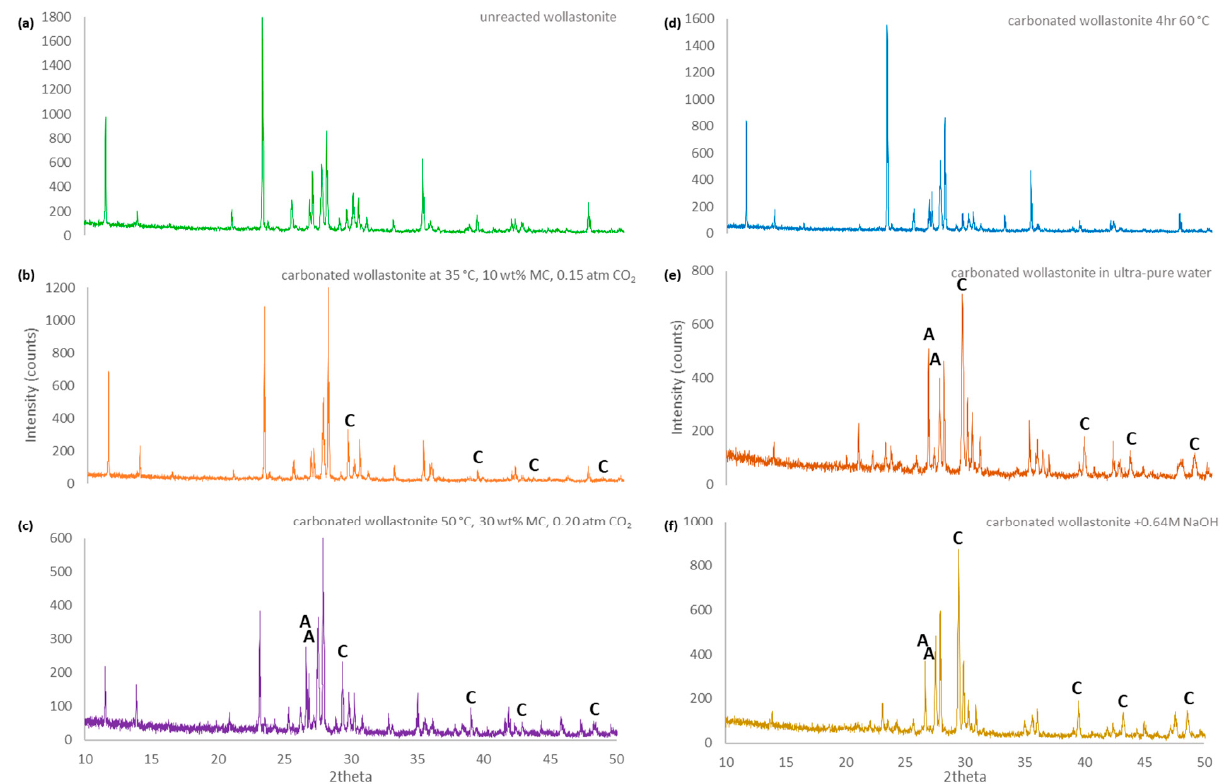
Figure 9. XRD diffractograms of: ( a ) unreacted wollastonite; incubator carbonated (144 h) wollastonite at 35 °C, 10 wt% moisture content, and 0.15 atm CO 2 ( b ) and at 50 °C, 30 wt% moisture content, and 0.20 atm CO 2 ( c ); ( d ) slurry carbonated wollastonite; pressurized slurry carbonated wollastonite at 200 °C and 60 bar in ultrapure water ( e ) and in 0.64 M NaOH ( f ). The letters A and C indicate peak locations of aragonite (CaCO 3 ) and calcite (CaCO 3 ), respectively.